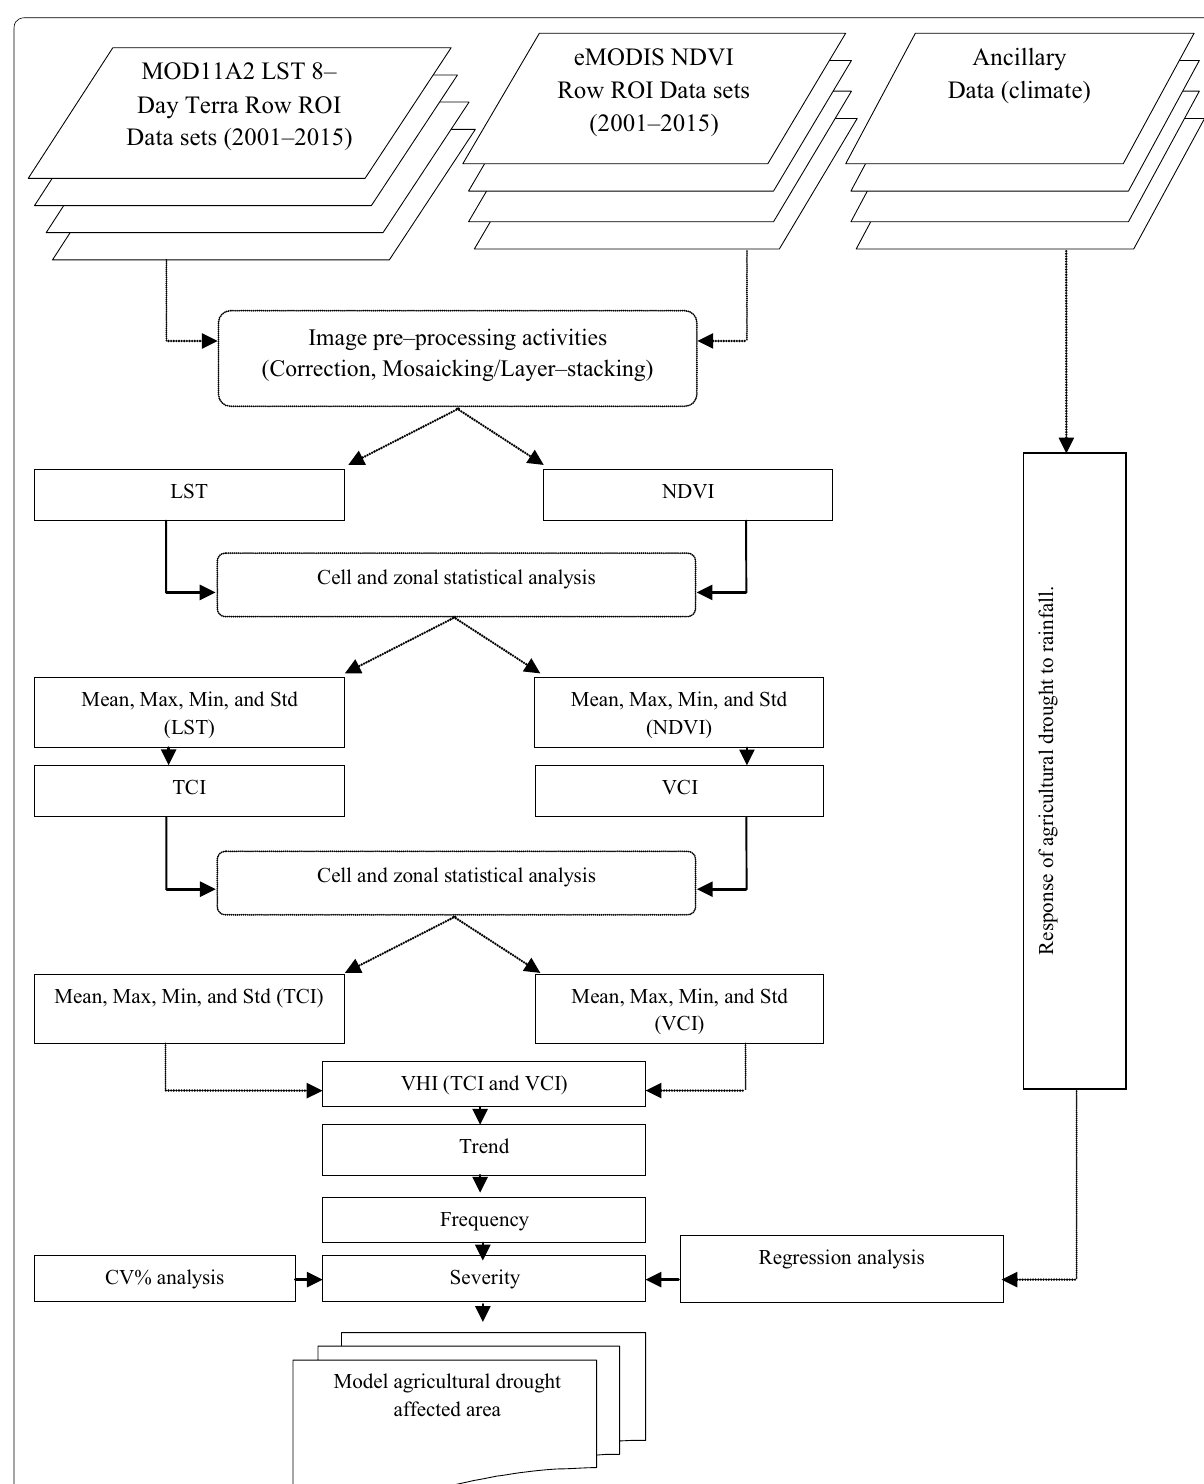
Fig. 2 Schematic diagram of agricultural drought analysis using an integrated approach of LST, VCI, NDVI, and